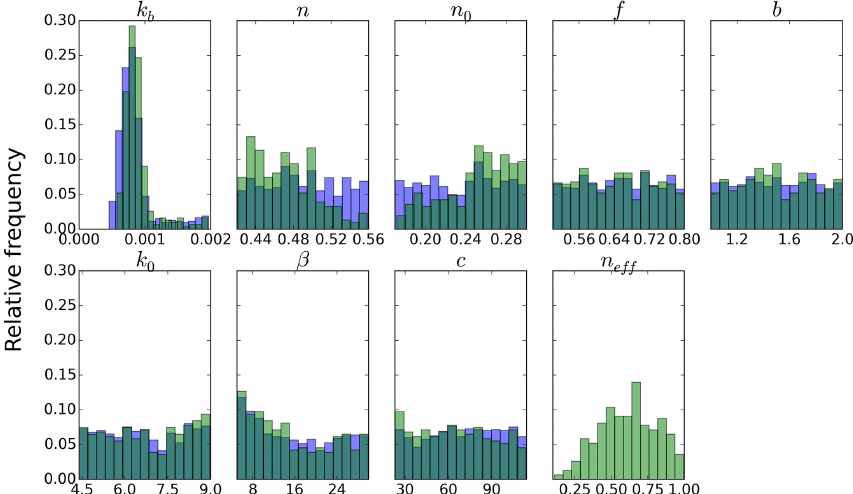
Figure 7. Relative frequency plots of the 796 behavioral parameter sets (in blue) based on lateral subsurface flow (Model 1) and relative frequency plots of the 308 behavioral parameter sets (in light green) based on lateral subsurface flow and δ 2 H (Model 2). Where the two parameter sets overlap, the color is dark